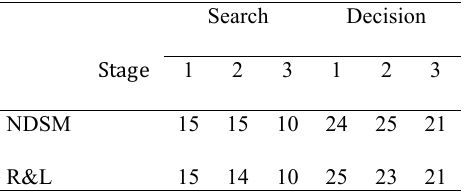
Table 2. Presence of stages, represented by number of partici-